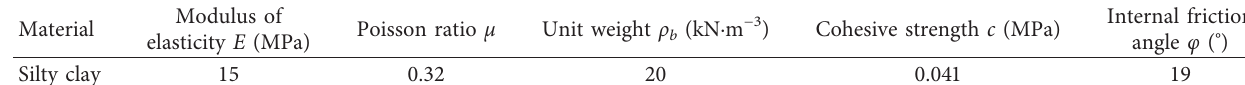
Figure 8: Tunnel excavation model with cavity. (a) Axonometric drawing. (b) Front elevation. Table 3: Soil physical and mechanical parameters.